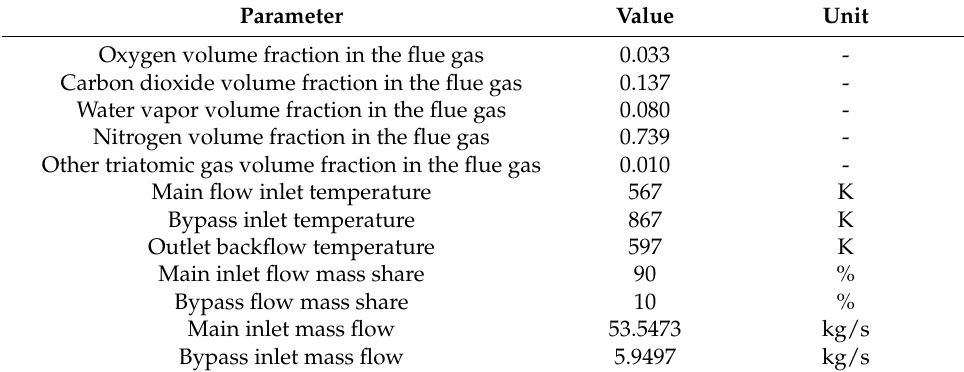
Table 2. Flue gas composition and the main boundary conditions.